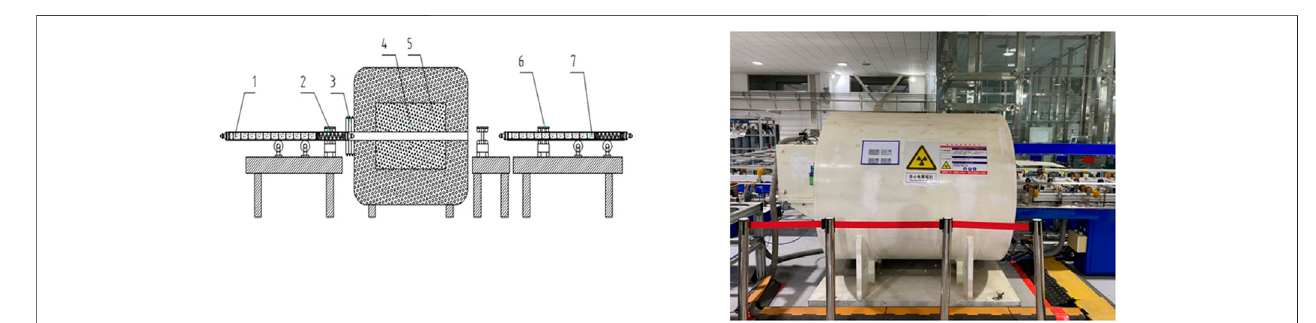
FIGURE 4 | Schematic diagram of neutron activation